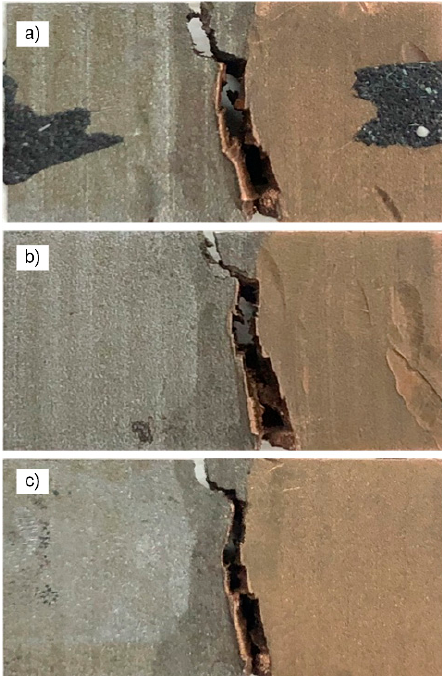
Figure 11. Macroscopic crack propagation of three-point bending specimen ( a ) for specimen 1; ( b ) for specimen 2; and ( c ) for specimen 3; steel on the left and copper on the right. The three-point bending fracture was observed at 1000 times magnification while using SEM.